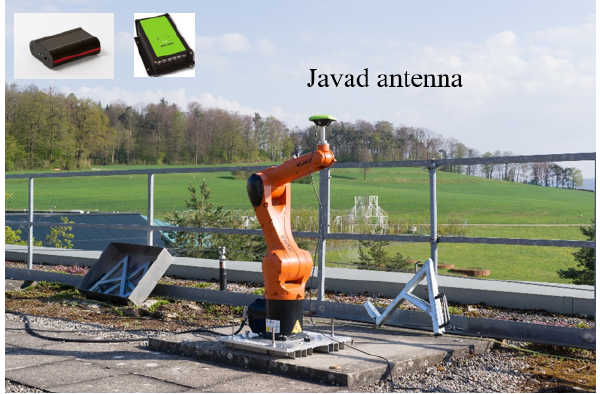
Figure 2. Experimental setup for the dynamic tests (session 1): a seismic strong-motion waveform was simulated using a KUKA robot arm. The same GNSS hardware was used as for the static kinematic test for station MON1.